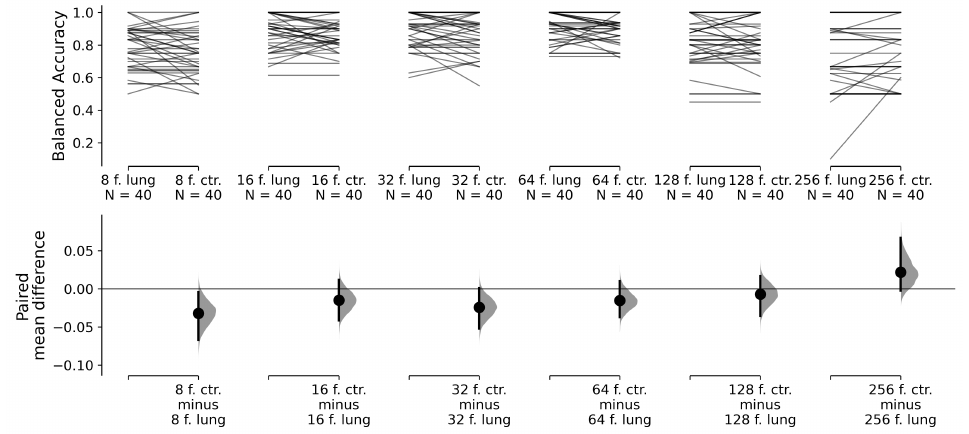
Figure 6. The paired mean difference of balanced accuracy for five classifiers are shown above in the Cumming estimation plot. The raw data is plotted on the upper axes; each paired set of observations is connected by a line. On the lower axes, each paired mean difference is plotted as a bootstrap sampling distribution. Mean differences are depicted as dots; 95% confidence intervals are indicated by the ends of the vertical error bars. (f.: frames; ctr.: centroid slice selection; lung: lung slice